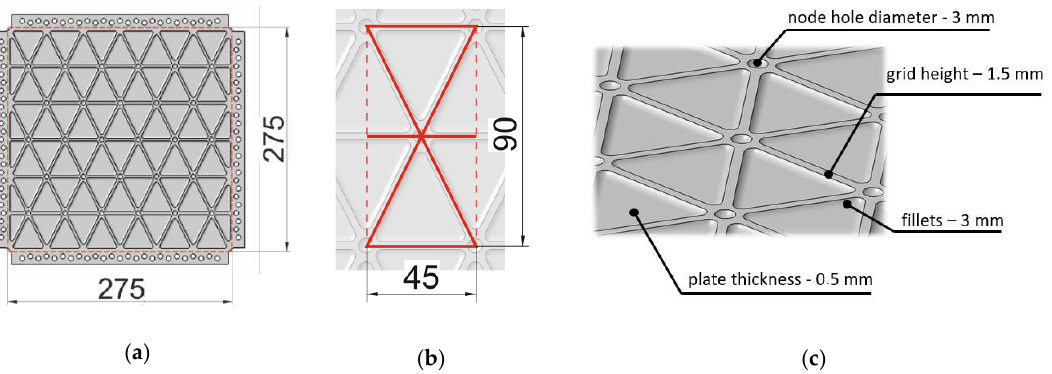
Figure 2. The geometry of the tested plate: ( a ) overall dimensions, ( b ) grid geometry, ( c ) detailed dimensions of the grid components.